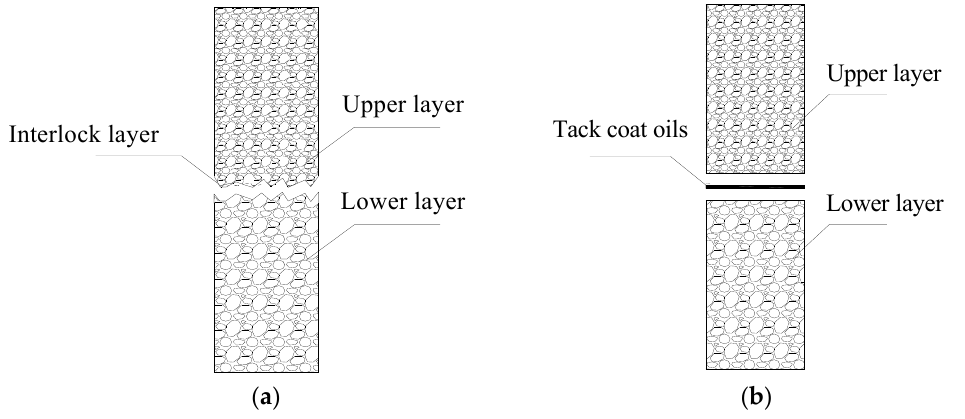
Figure 1. Illustration of the interface in the asphalt pavement constructed by: ( a ) double-decked paving method ( b ) conventional paving method.